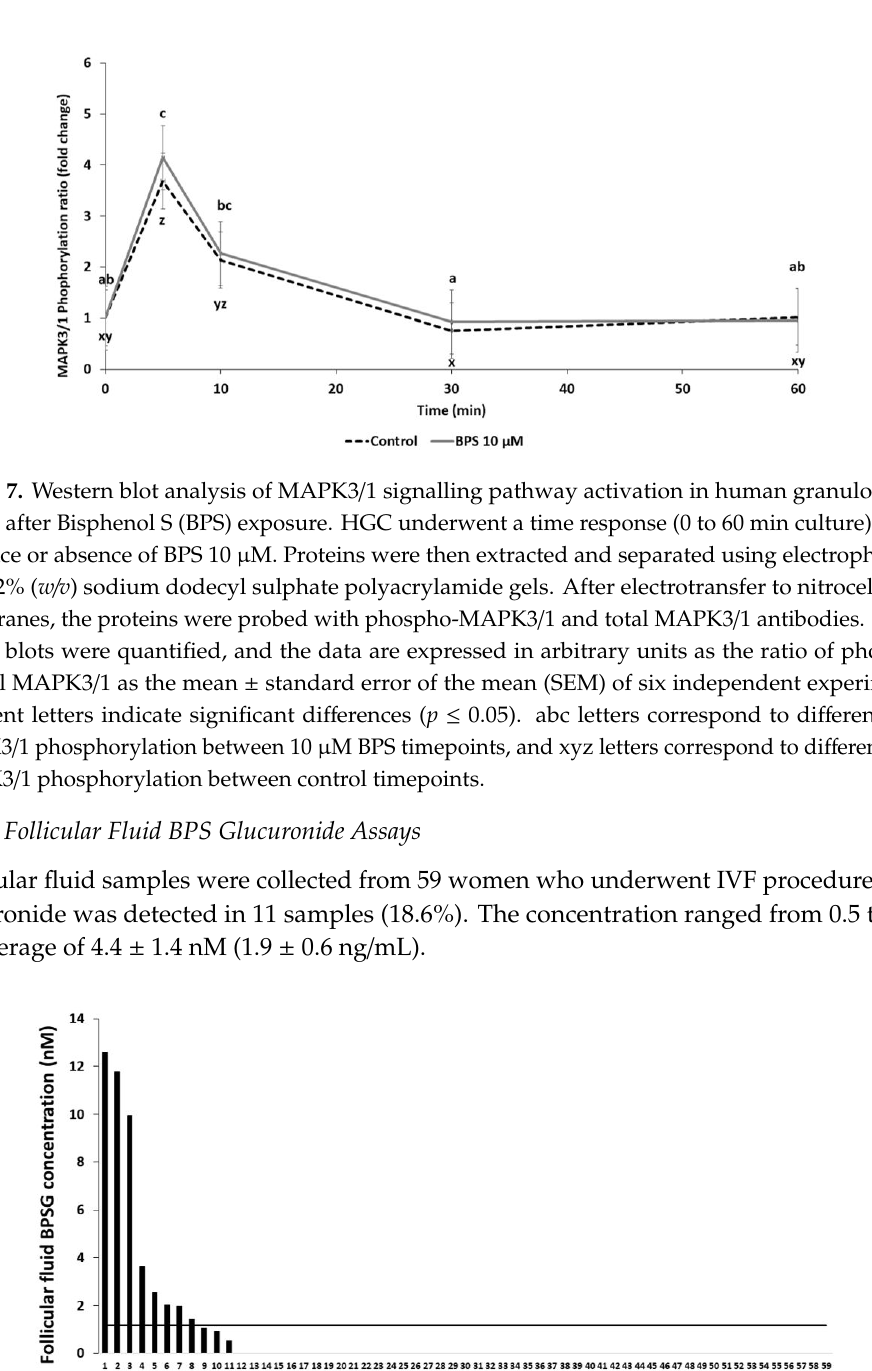
Figure 8. Female follicular fluid exposure to Bisphenol S (BPS). Follicular fluids from 59 women (in abscissa) were collected. Assays that measured BPS glucuronide (BPSG) were performed using ultraperformance liquid chromatography-tandem mass spectrometry (UPLC MS / MS). The limit of quantification (LOQ) value, presented with a horizontal black line, was 1.17 nM (0.5 ng / mL) for BPSG in female follicular fluid. The BPSG level is represented for each of the 59 women in